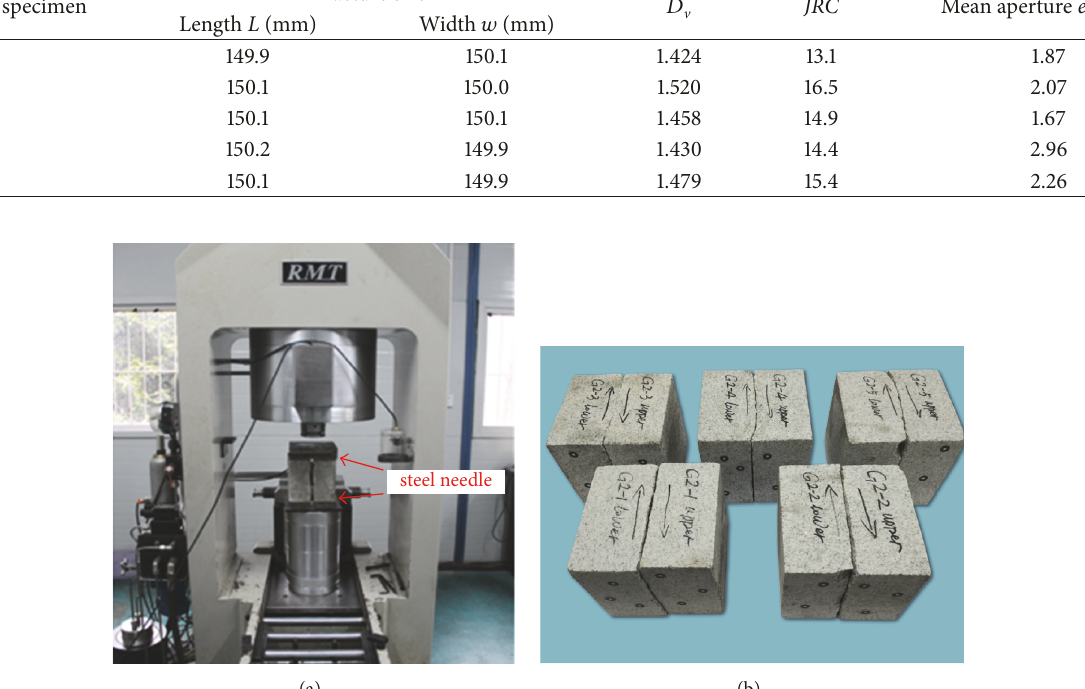
Figure 2: Creation of the model fractures: application of indirect Brazilian test in (a) and induced single fractures (Gr1, Gr2, Gr3, Gr4, and Gr5) in